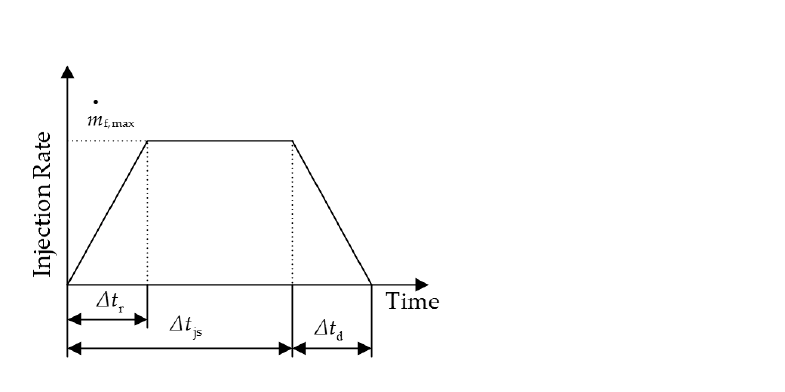
Figure 2. Injection rate pattern.